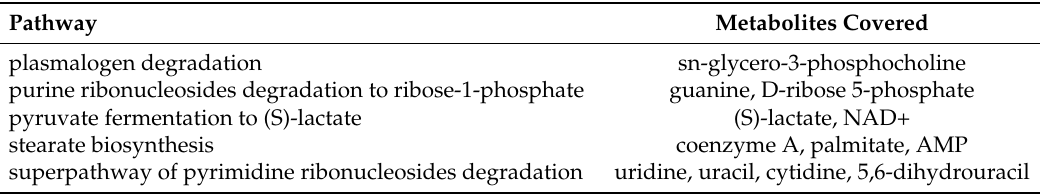
Table A14. McDonnell 2013, Pathway Covering Using Pathway Harmony Cost